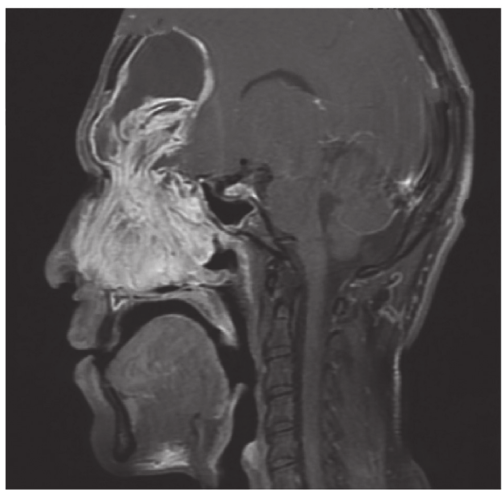
Figure 5: MRI of the brain and sinuses in the sagittal plane showing a significant expansion of both frontal sinuses caused by the mucopyoceles.